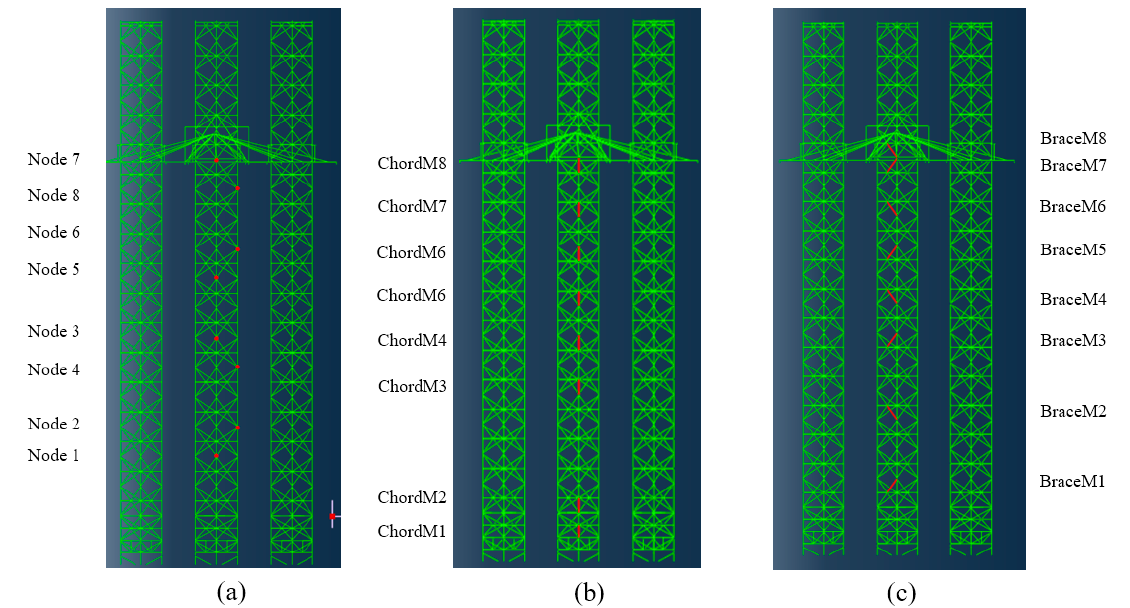
Figure 6. Location of ( a ) selected nodes, ( b ) chord members, and ( c ) bracing members on forward legs of the SEU for validation comparison (ChordM1 stands for chord member 1, BraceM1 stands for bracing member 1).